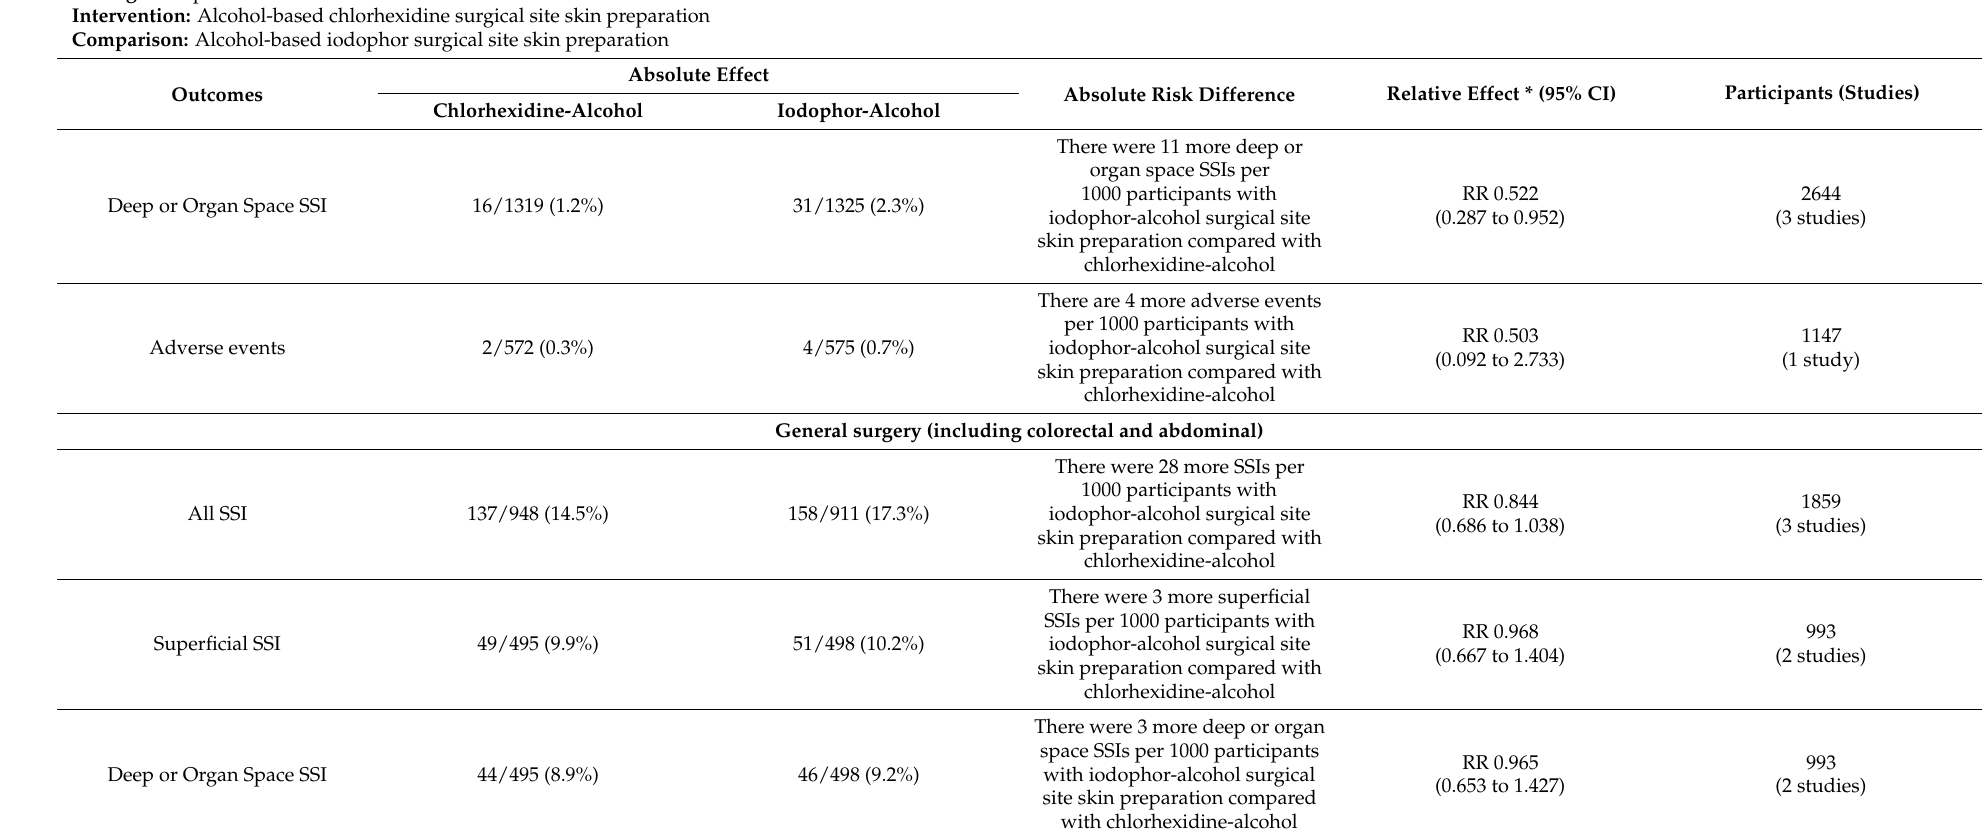
Patients or Population: Patients undergoing surgery Settings: